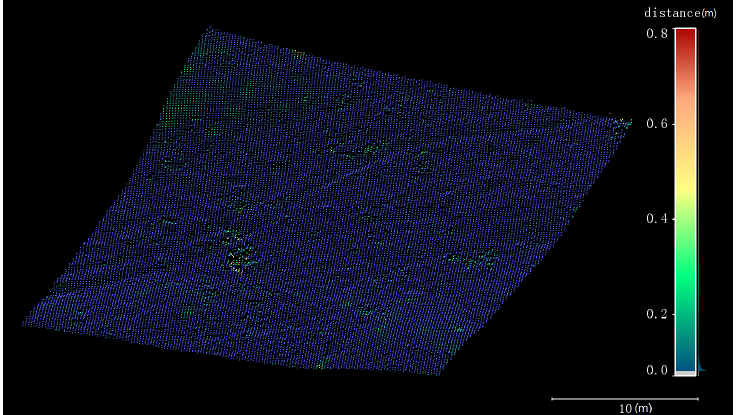
Figure 5. DTM 3 ‐ D points extracted from the plot ‐ 1 multiple scans (MS) dataset. Point distance between extracted DTM and reference DTM is rendered using color legend on the right. A scale bar is placed at lower right corner.